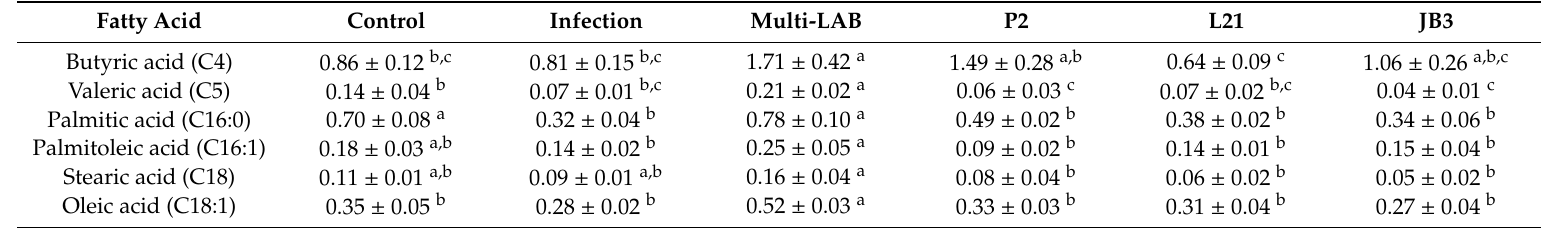
Table 2. E ff ects of LABs on fatty acid concentrations ( µ M) in serum of H. pylori infected mice. Values are mean ± SEM, n = 10. a–c Values in a row without a common letter di ff er, p <